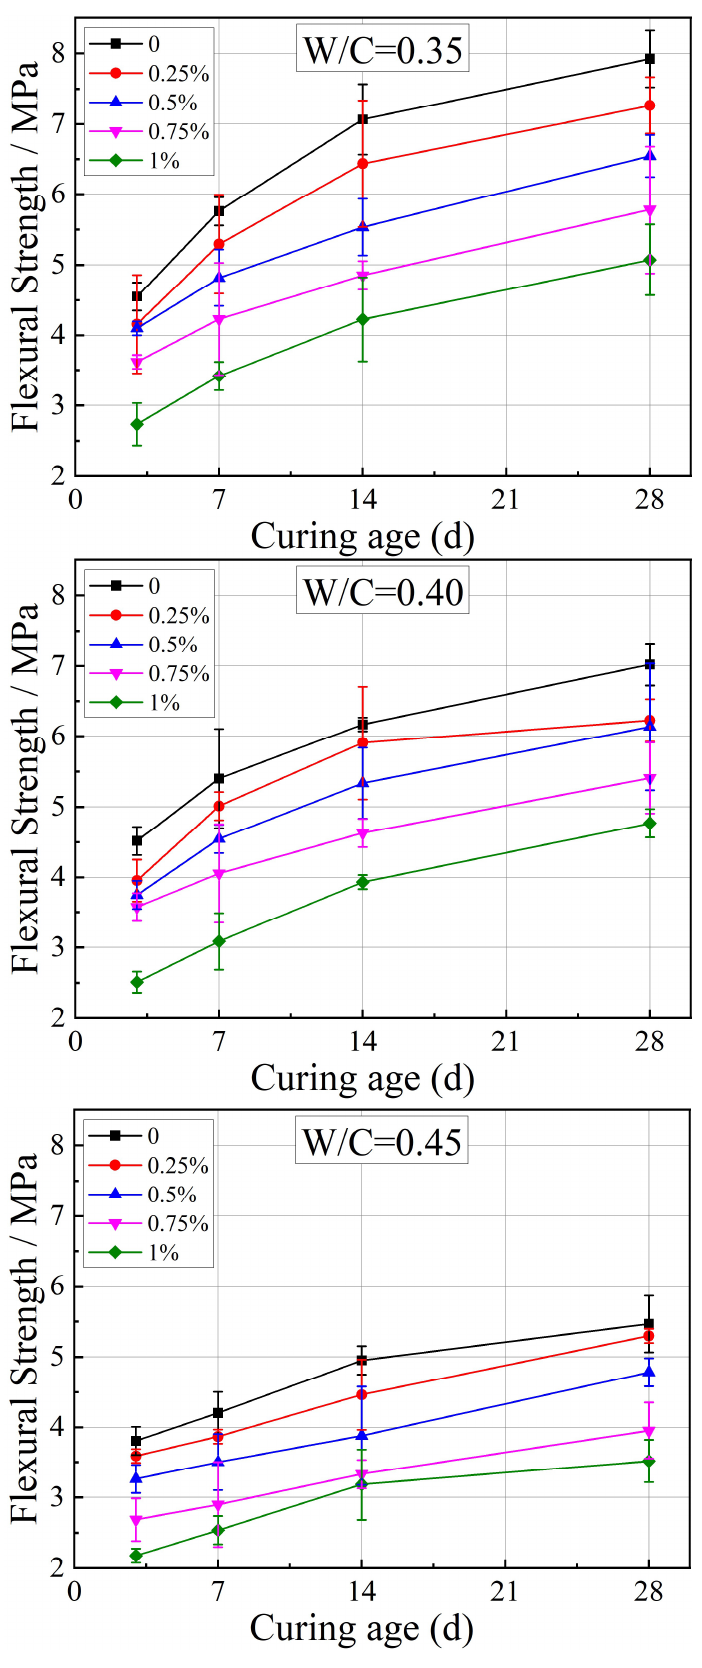
Figure 3. Flexural strength of samples with different W/C ratios (0.35, 0.4, and 0.45), ages (3 d, 7 d, 14 d, and 28 d), and SAP components (0%, 0.25%, 0.5%, 0.75%, and 1%).